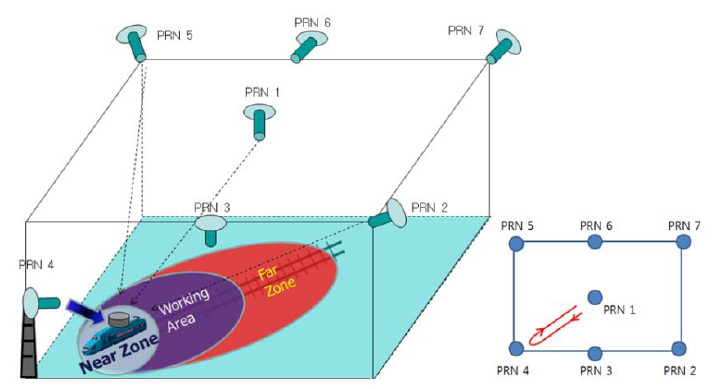
Figure 17. Test 2: Test setup and user trajectory.